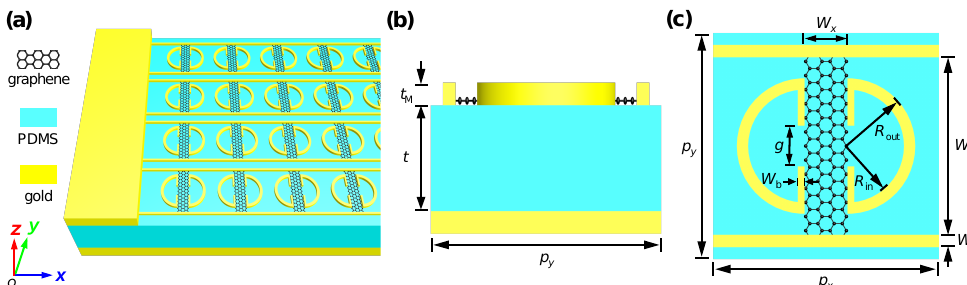
Figure 1. Schematic of the proposed metasurface, the unit cell of which is composed of gold stripes, gold asymmetric split rings and a graphene patch on top of a thick gold film sandwiched with a PDMS spacer: ( a ) 3D view; ( b ) side view; and ( c ) top view. p x = p y = 240 µ m; W s = 4 µ m; R out = 90 µ m; R in = 75 µ m; W b = 7.5 µ m; g = 60 µ m; W x = 24 µ m; W y = 228 µ m; t M = 200 nm; and t = 45 µ